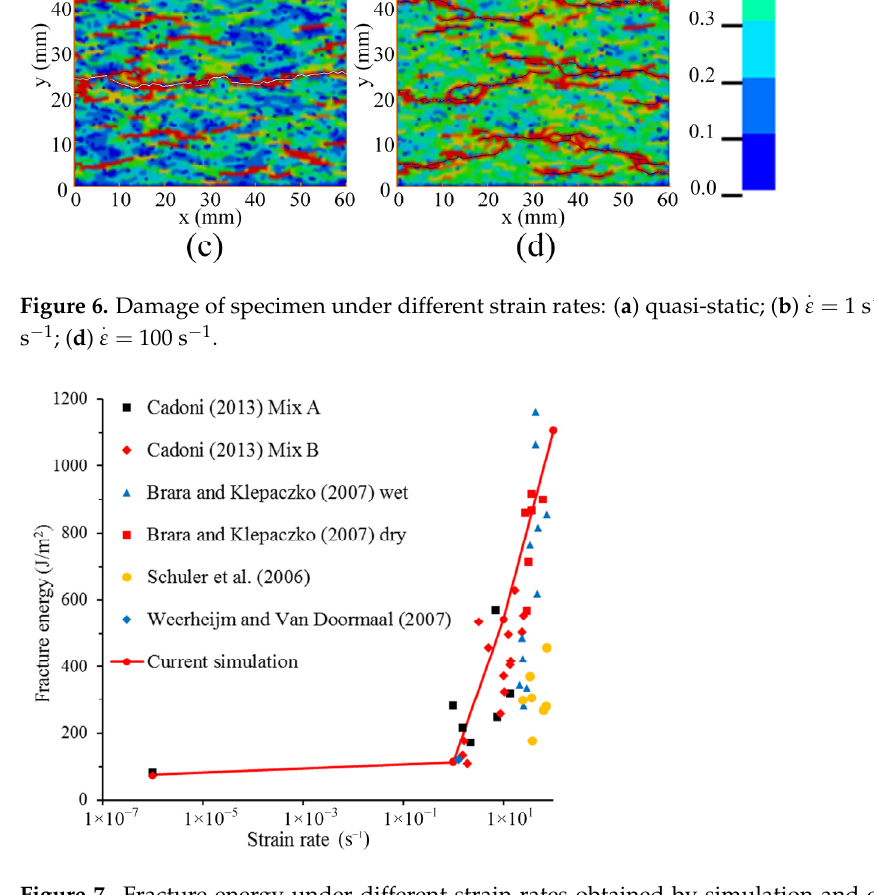
Figure 7. Fracture energy under different strain rates obtained by simulation and experimental results [2]. results